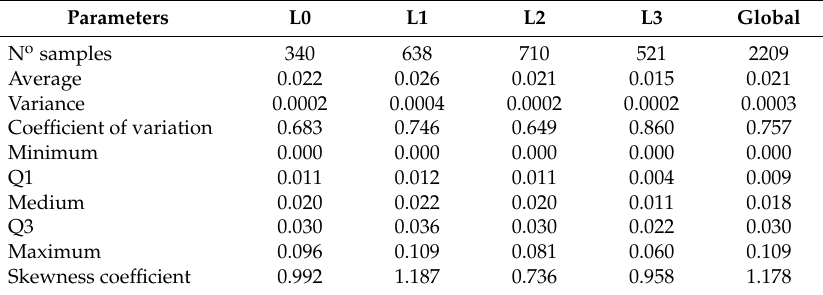
Table A5. Borehole vein proportion statistics.